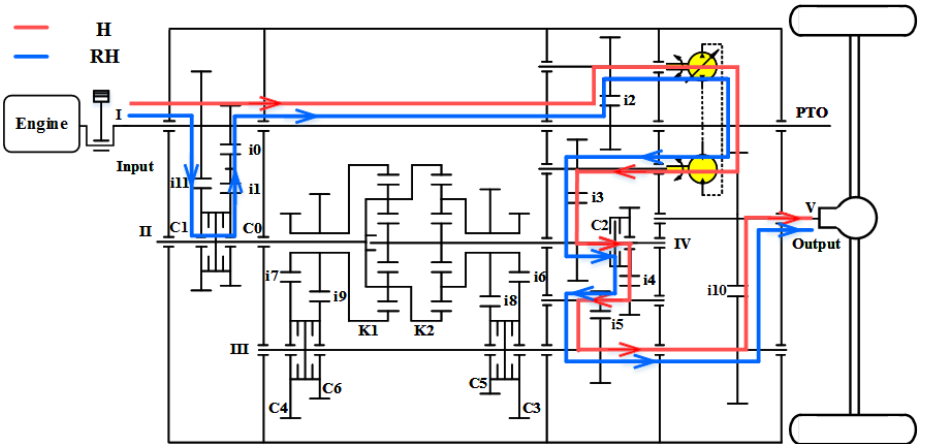
Figure 8. Power flow in pure hydraulic section. Table 6. HMCVT shift clutch logic. (+: engage; − separate). Direction